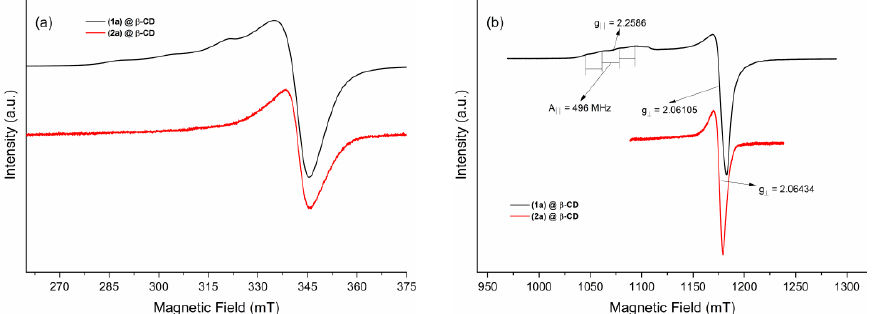
Figure 7. X-band (9.879 GHz frequency) ( a ) and Q-band (34.16 GHz frequency) ( b ) powder EPR spectra of inclusion complexes ( 1a )@ β -CD and ( 2a )@ β